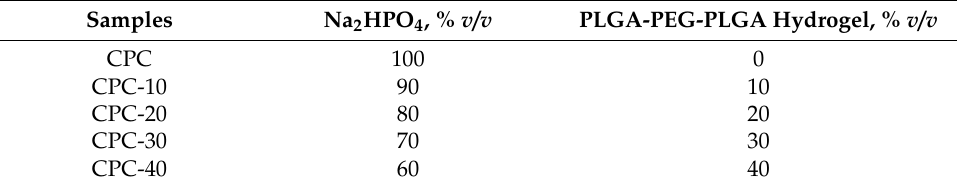
Figure 1. Schematic representation of the preparation process of PLGA-PEG-PLGA hydrogel / calcium phosphate cement composites (PLGA-PEG-PLGA / CPCs).